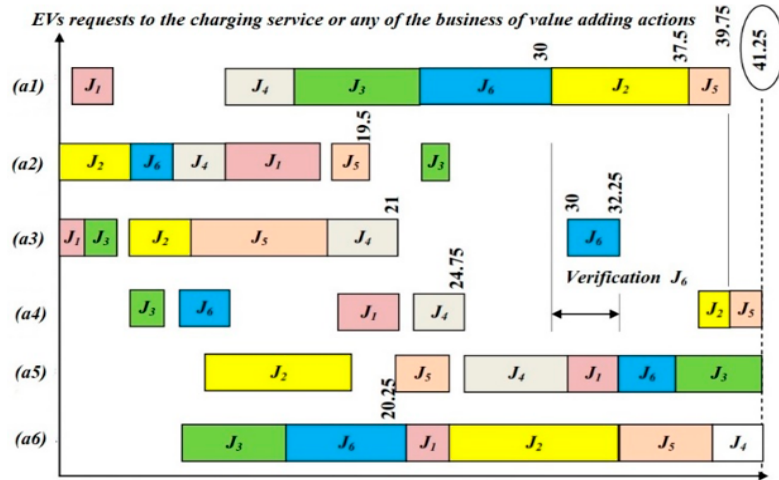
Figure 13. The solution of service span time by proposed methodology aided by AIoT management.